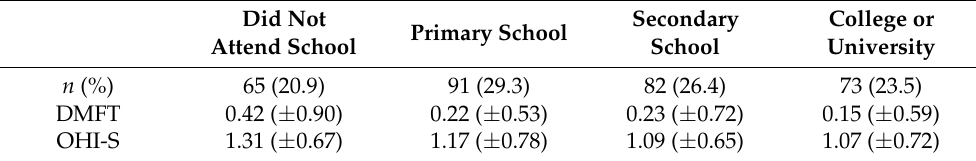
Table 3. Mean DMFT und OHI-S ranked according to parental level of education.